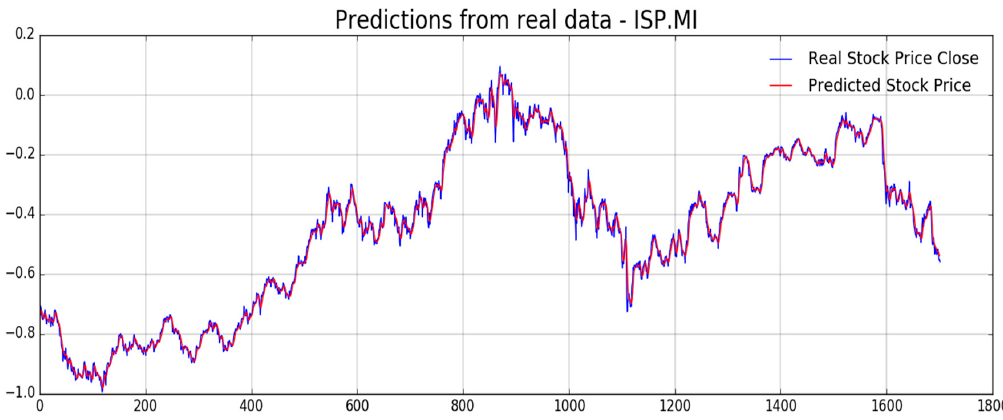
Figure 15. ISP.MI Close Price time-serie (red: predicted without Markov correction; blue: real value).